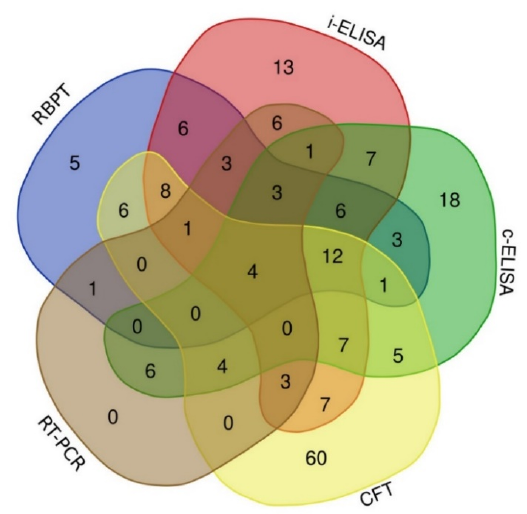
Figure 2. Venn diagram showing the agreement of positive results of serological tests and real-time PCR.